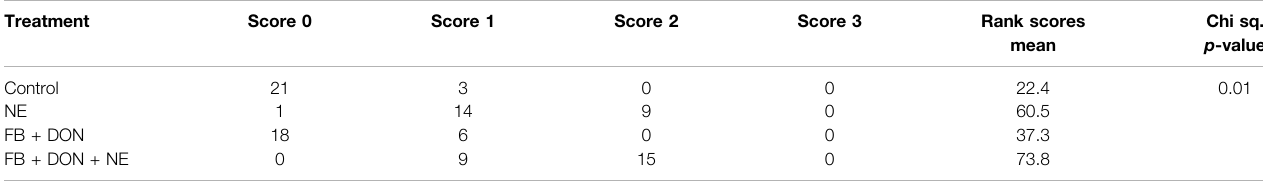
Day-oldchicksweredistributedintofourtreatmentgroups:control,necroticenteritis(NE),fumonisin+deoxynivalenol(FB+DON),andFB+DON+NEgroups.BirdsintheNEandFB+ DON+NE groupsreceived2.5×10 3 Eimeriamaxima oocystper birdonday14. Allbirdsreceived1×10 8 CFU/birdof Clostridiumperfringens ondays19, 20,and21.On day21,three birds were scored for NE lesion scores on a 0 to 3 scale wherein 0 is normal, 1 shows slight mucus covering the small intestine, 2 has a necrotic small intestinal mucosa, and 3 shows sloughed cells and blood in the small intestinal mucosa and contents. Lesion scores were analyzed by a non-parametric test, and Wilcoxon/Kruskal – Wallis rank-sum test was used to separate the means.